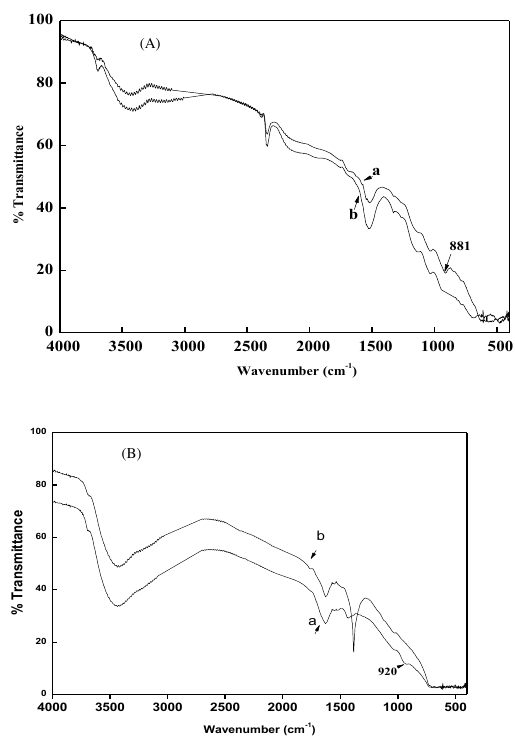
O (b) before and (a) 2 3 O (b) 2 3